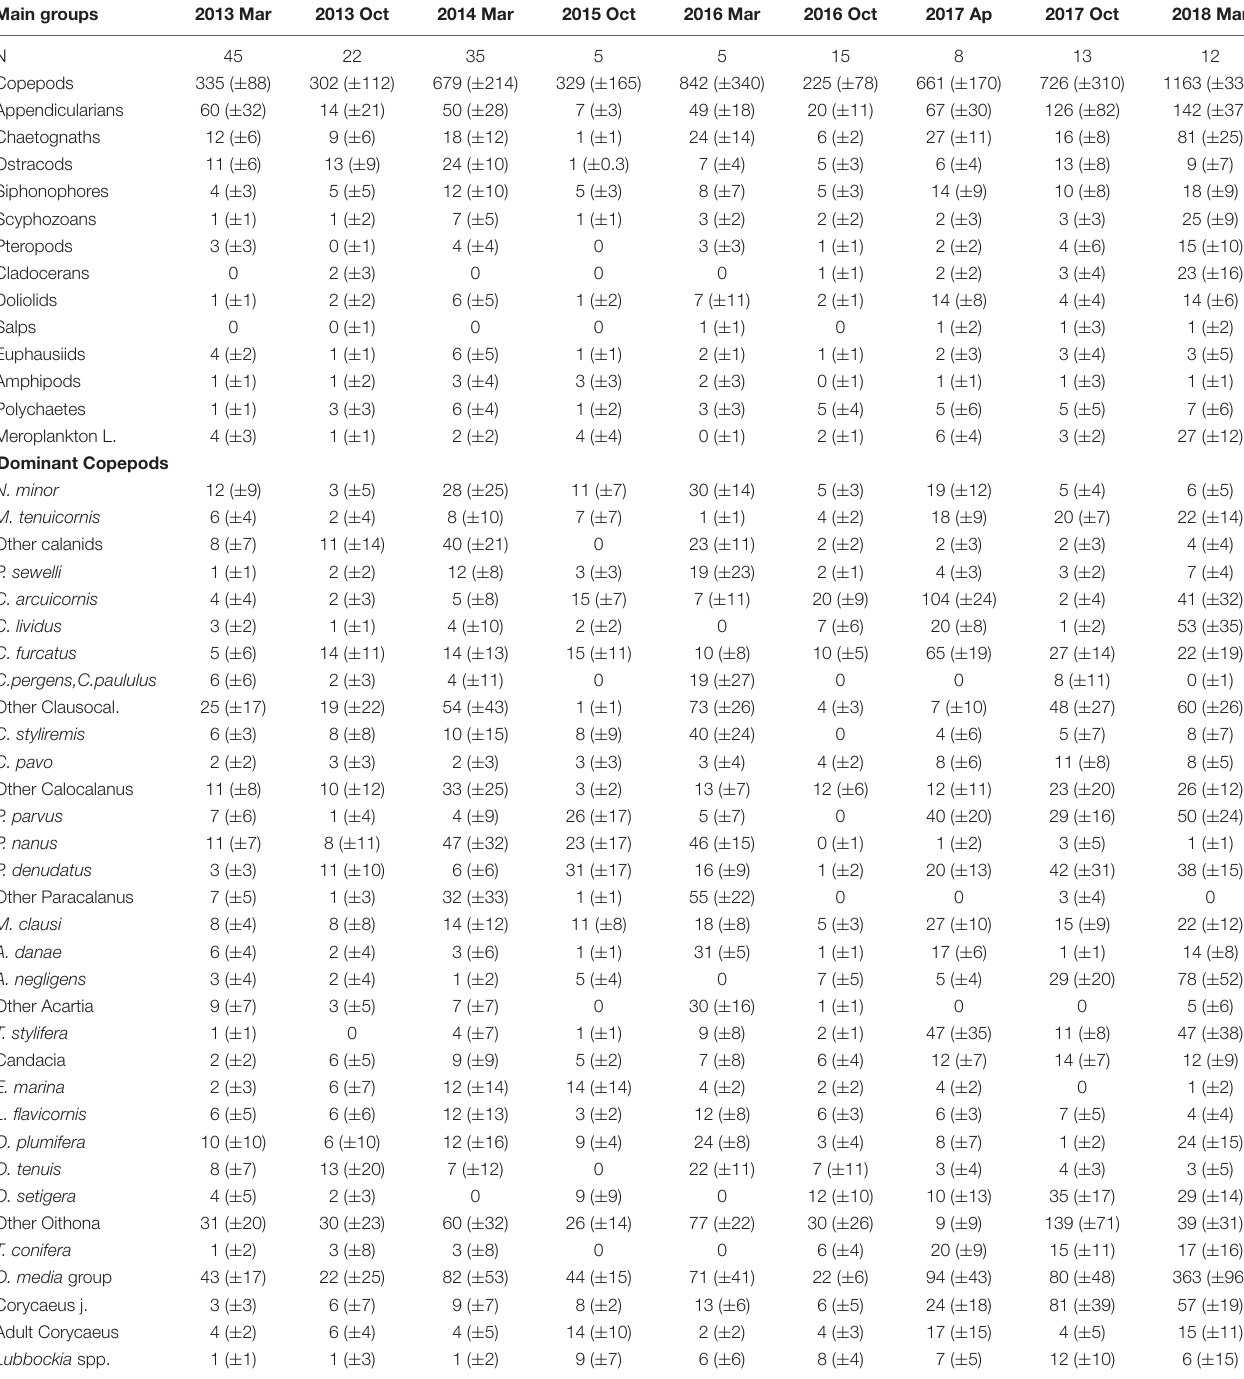
TABLE 2 | Abundance average and standard deviation ( ± SD) of main zooplankton groups (ind m − 3 ) and the dominant copepods at each survey ( > 1%). Main